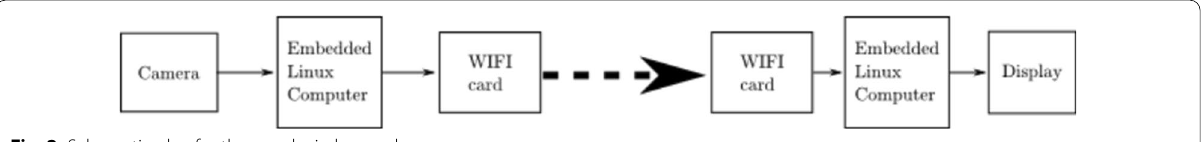
Fig. 2 Schematic plan for the novel wireless